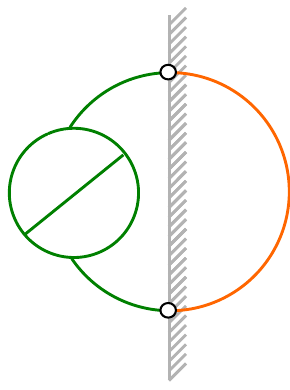
Figure 4 . A bubble halfway absorbed into a symmetric boundary condition drawn for D = 2 . The bulk G B -foam is drawn in green. Where it ends on the boundary (white circles) there is a possible gravitational anomaly, described by a function β 1 : G B → Ω 1 , which in a spin theory could be a fermionic operator, Ω 1 = Z 2 . This gravitational anomaly means that the G B -foam with spin boundary is not isotopy invariant, and so we cannot apply the argument we gave in section 3 for theorem 3. However, by introducing the subliminal G B -foam (orange) carrying the invertible phase corresponding to β 1 (for Ω 1 it is a fermionic world line) the gravitational anomaly is cured and spin the entire object is isotopy